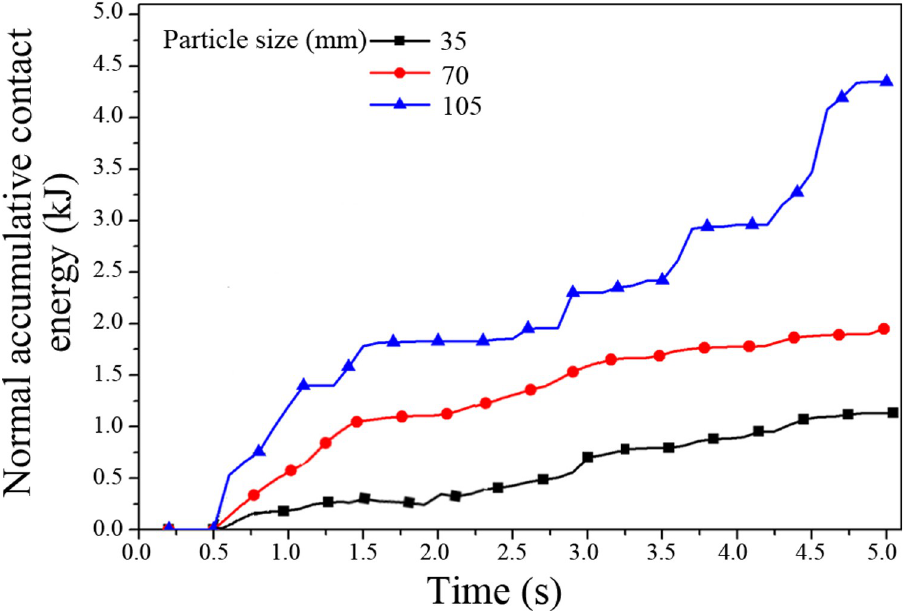
Fig 13. Curve of the normal accumulative contact energy of the middle trough caused by raw coal with different particle sizes.